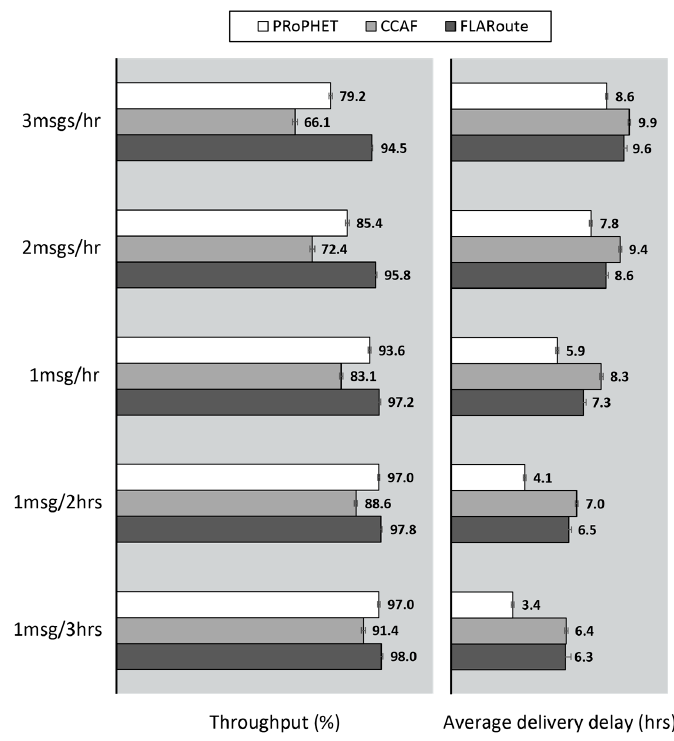
Figure 23. Throughput and average delivery delay under increasing data traffic in the Helsinki scenario.